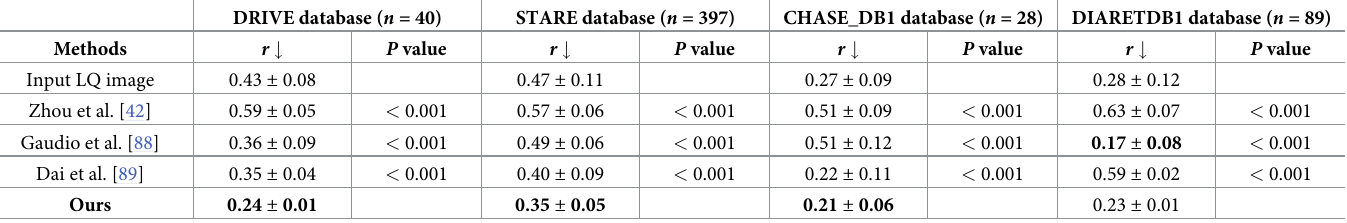
Table 2. Quantitative comparison on public